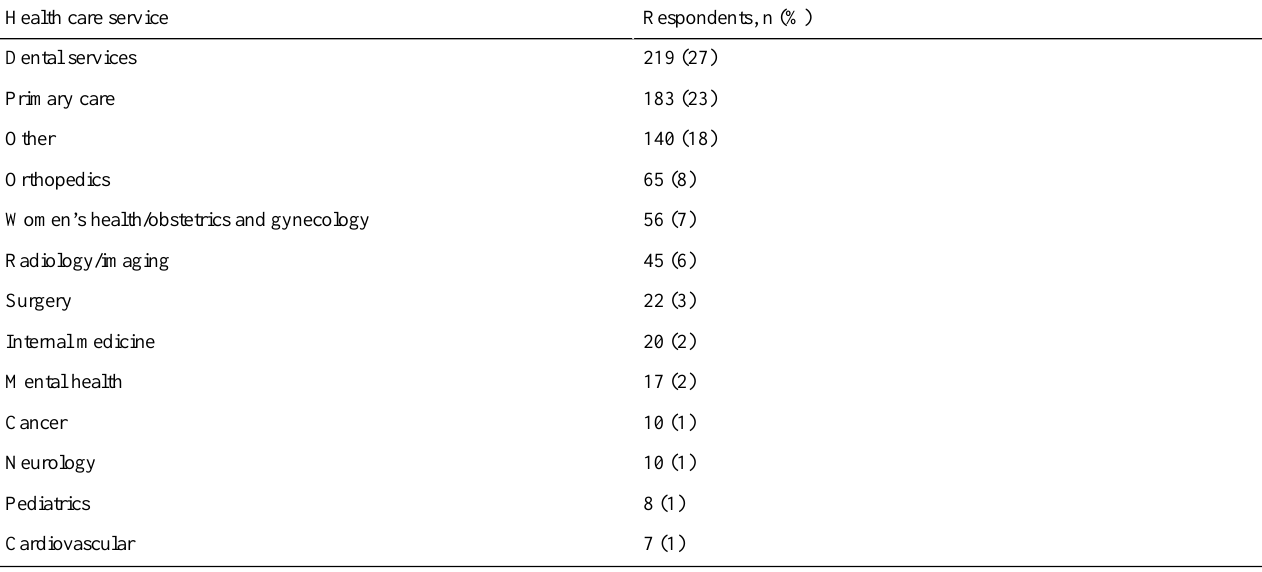
Table 2. Delayed care by service line among 803 survey respondents in Vermont between April 30 and May 13, 2020, who reported deferring care due to the COVID-19 pandemic medical services shutdown.